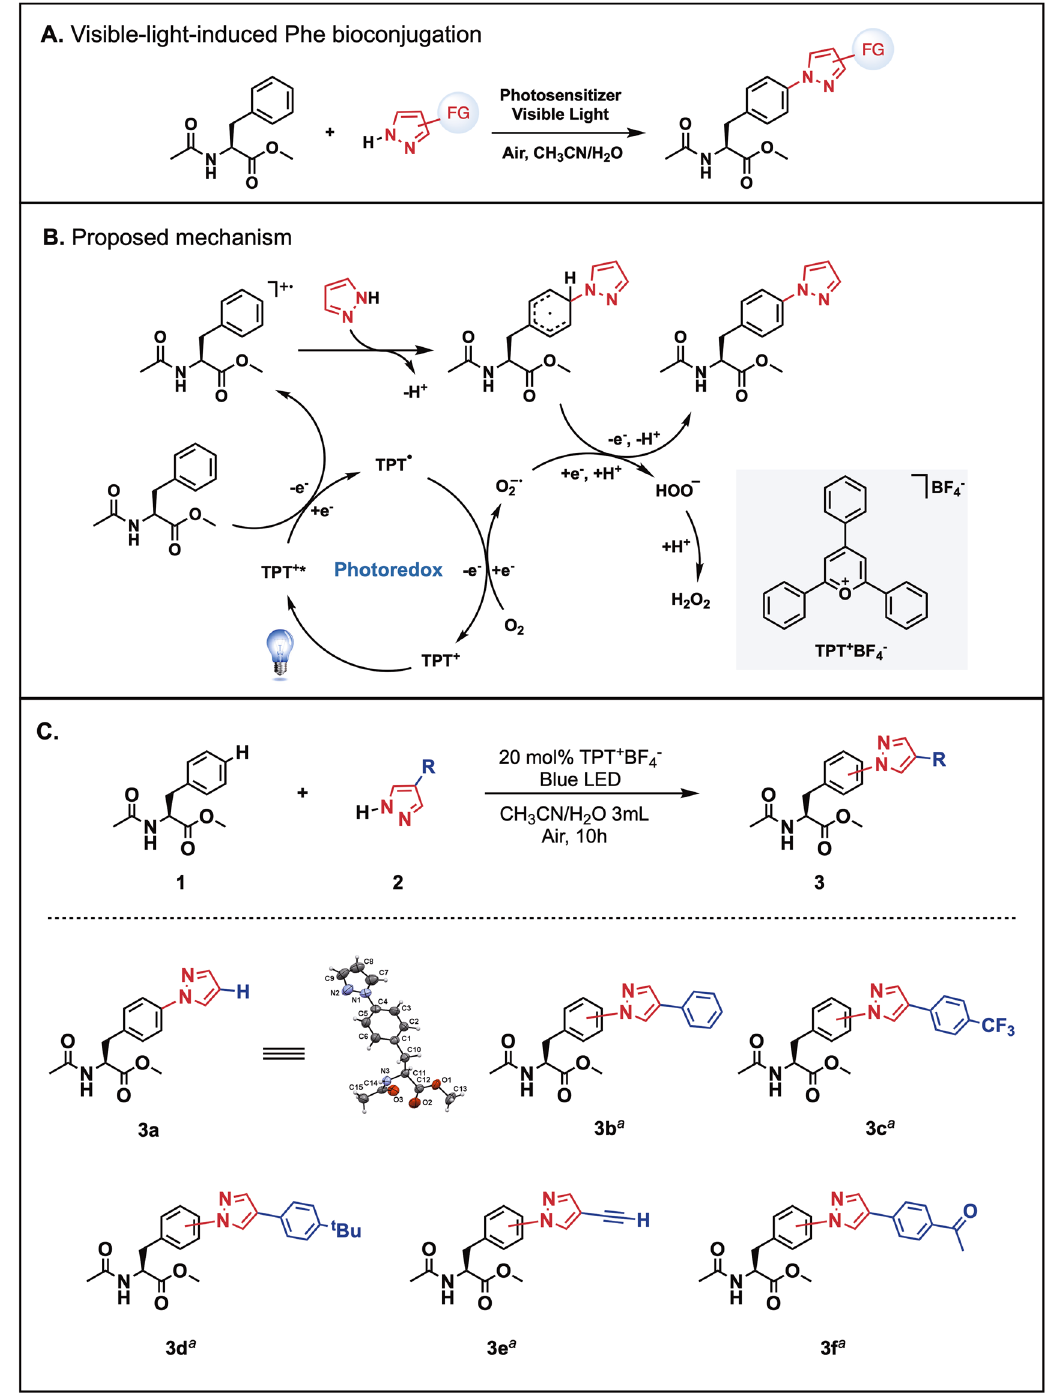
Figure 2. Visible-light-induced phenylalanine bioconjugation. ( A ) Reaction model of visible-light-induced phenylalanine conjugation under mild and atmospheric conditions. ( B ) The proposed mechanism for the reaction between phenylalanine and pyrazoles. ( C ) The molecular structure of 3a was determined by X-ray crystallography. Conversion of the starting Phe 1 into the corresponding aminated products was confirmed by LC–MS. a The corresponding products were detected in LC–MS with less than 10%